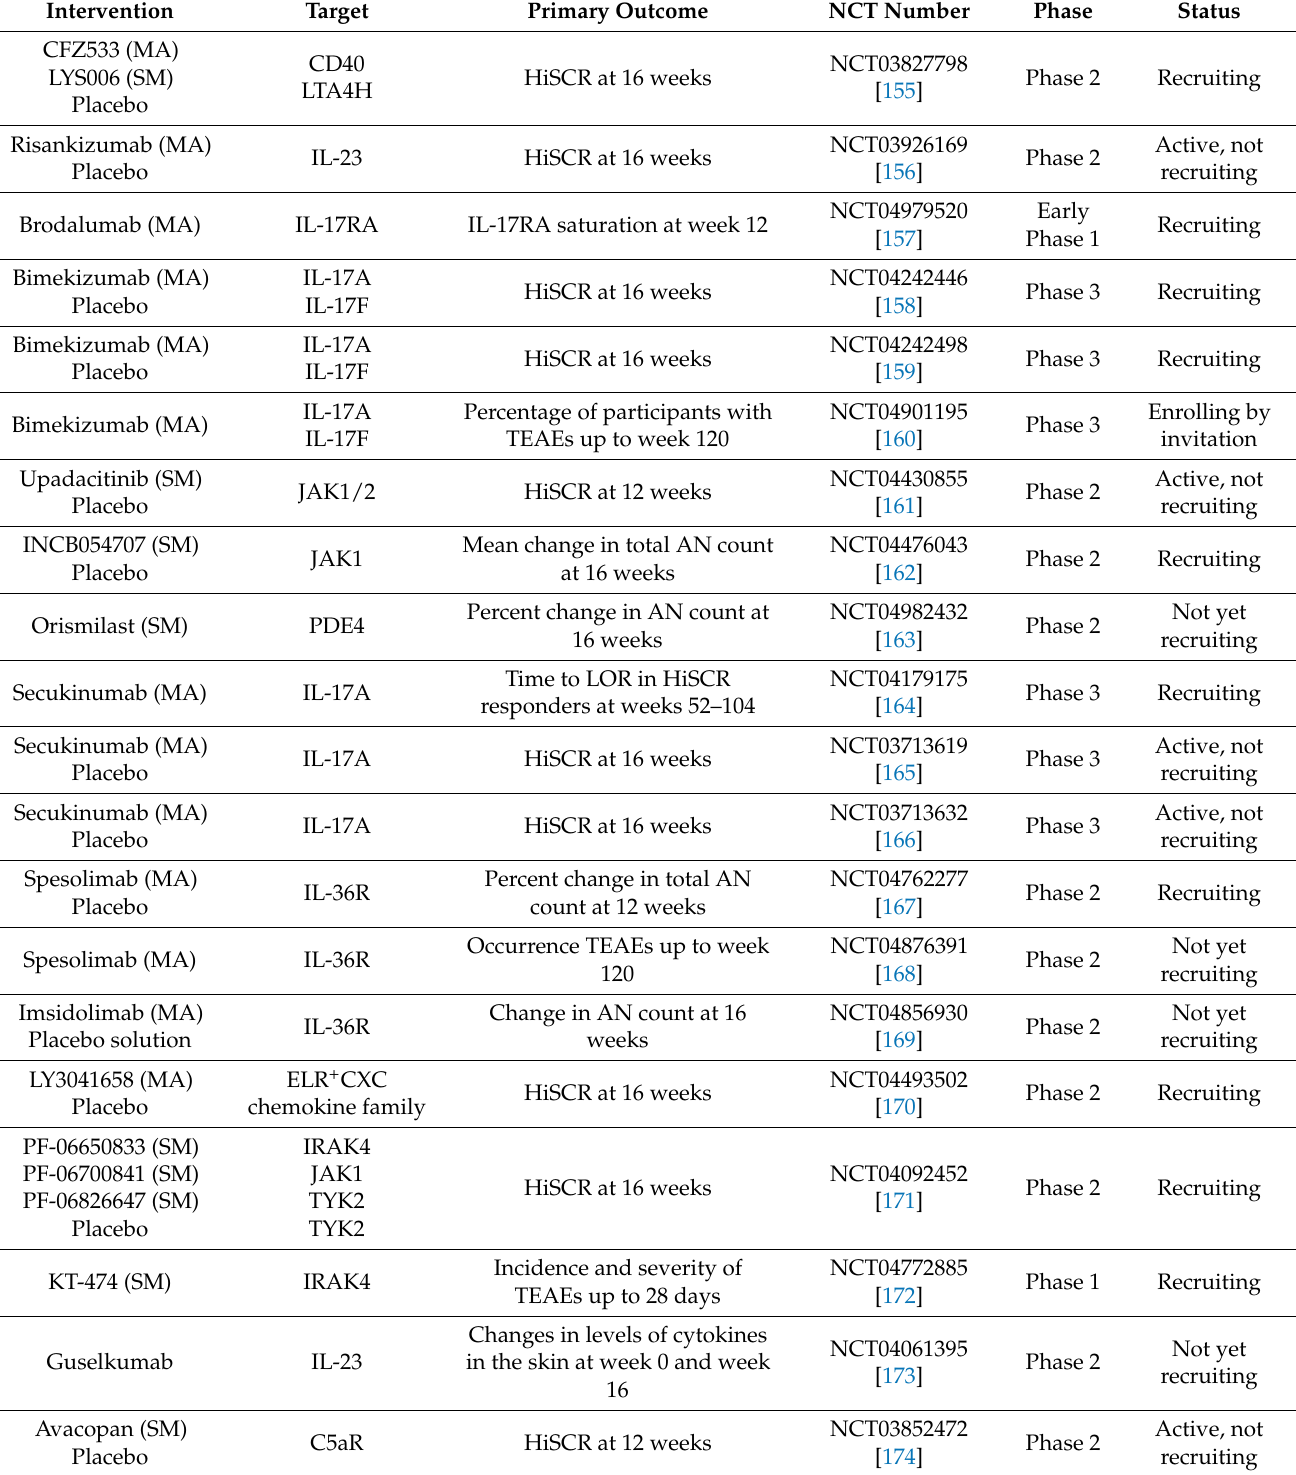
Table 1. The complete list of ongoing clinical trials focusing on biologic and small-molecule